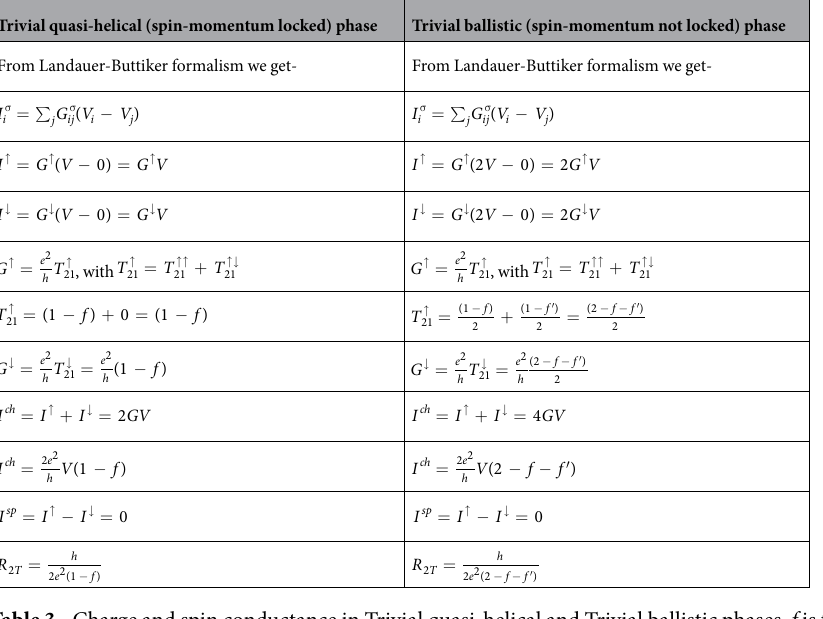
Table 3. Charge and spin conductance in Trivial quasi-helical and Trivial ballistic phases. f is the probability of spin-flip scattering, and f ′ is the backscattering probability which is non-zero only for trivial ballistic phase. Left column has edge modes while write column has ballistic modes and therefore for f ′ = 0, R 2 T for ballistic case does not reduce to that of edge state.